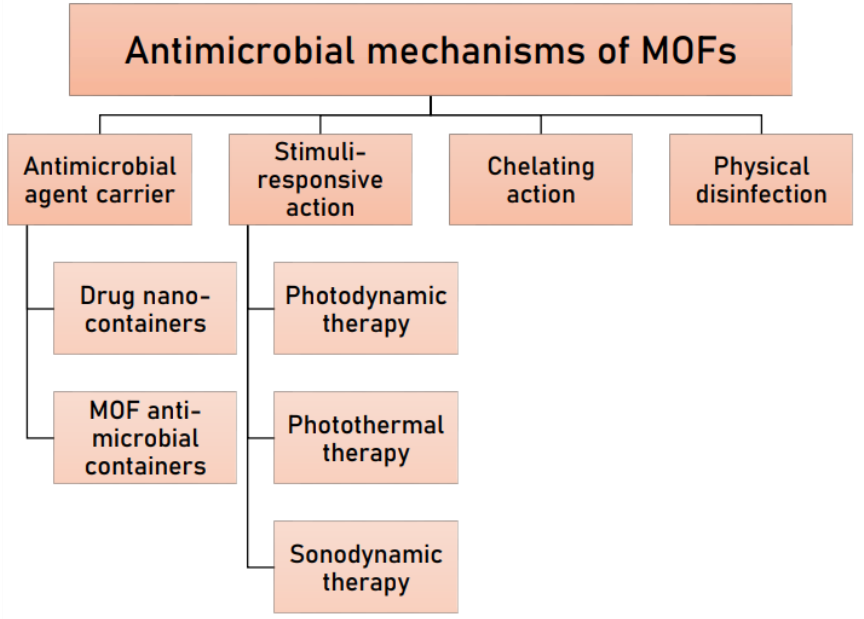
Figure 5. A scheme showing the different mechanisms of the antimicrobial action of MOFs that are discussed in this review.